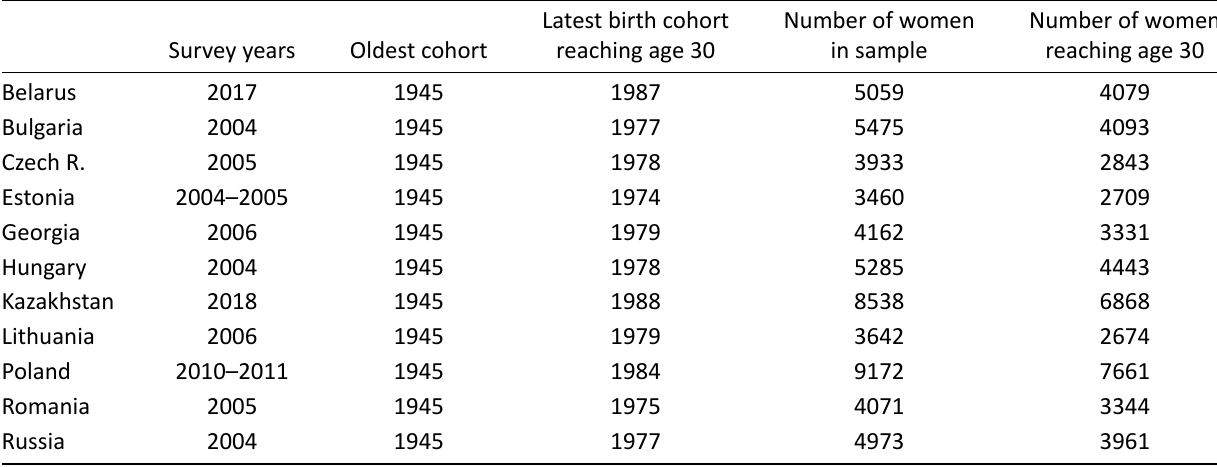
Table 1. Descriptive information related to the Harmonized